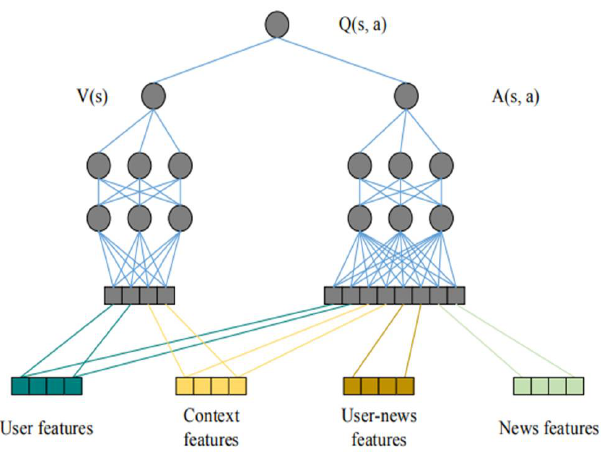
Figure 4. Q network structure. (4) Directional Derivative Projection Policy Optimization (DDPPO) Algorithm